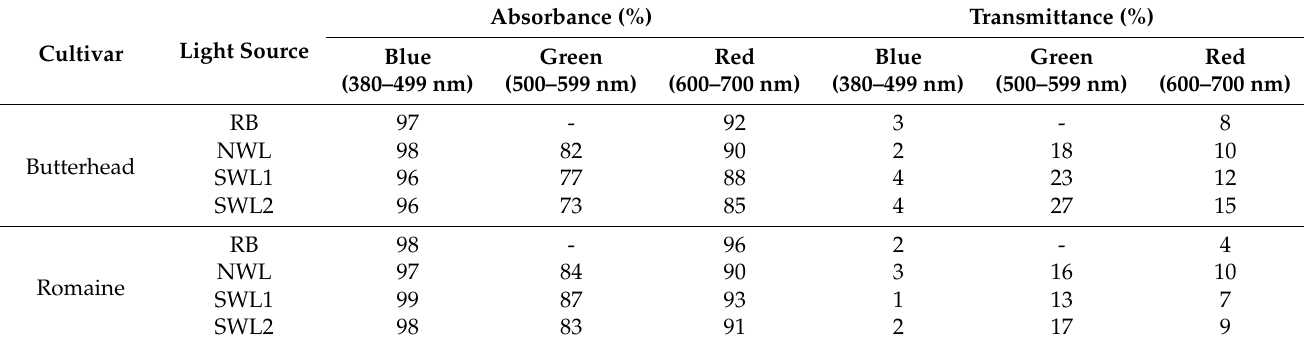
Table 3. Absorbance and transmittance of butterhead and romaine lettuce at each light source with the same electrical power.